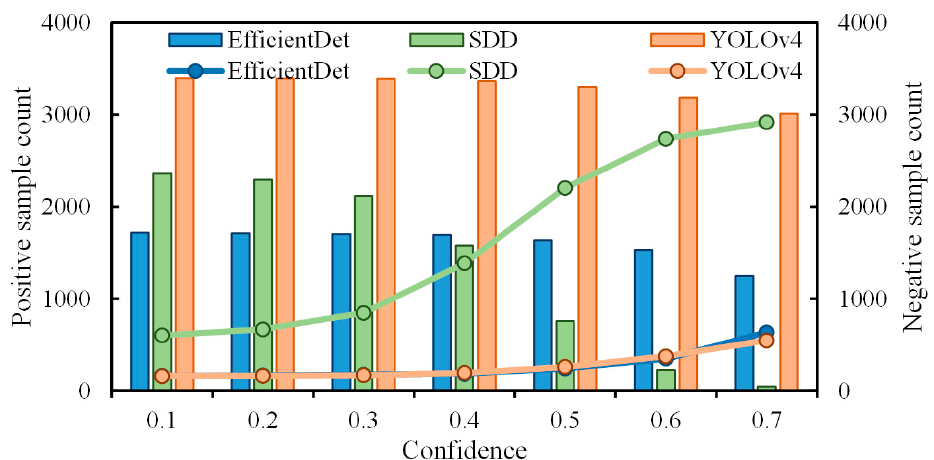
Figure 12. Statistical results of positive and negative sample numbers for each method with different